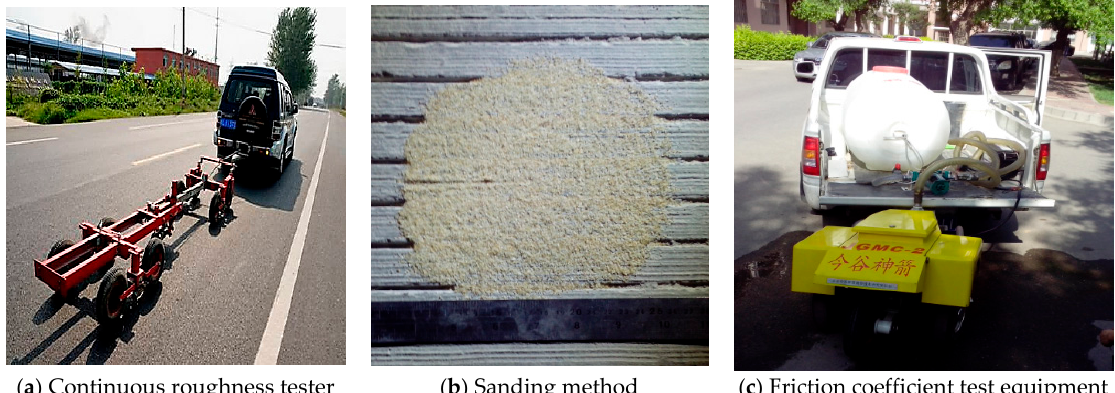
Figure 1. Test methods of concrete pavement texture.